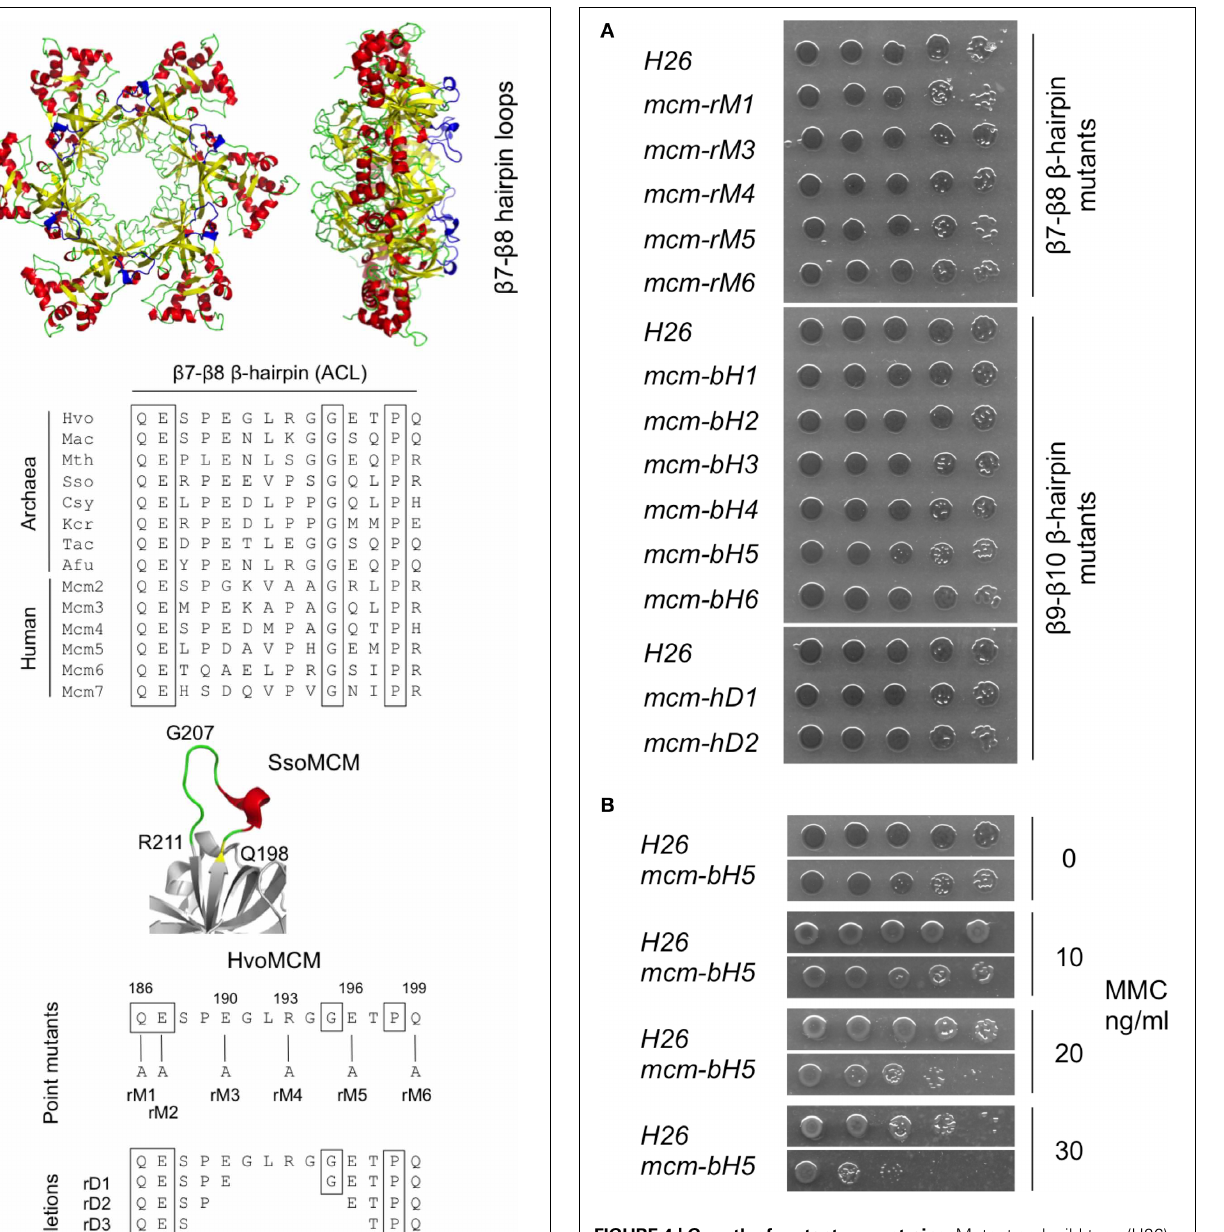
FIGURE 4 | Growth of mutant mcm strains. Mutant and wild-type (H26) strains were grown to mid-log phase in Hv-YPC medium (OD 650nm of 0.2–0.32) before being serially diluted in 18% SW and spotted onto Hv-YPC plates (part A ) or Hv-YPC plates containing 0, 10, 20, or 30ng/ml mitomycin C (MMC, part B, only H26 and mcm-bH5 are shown). The plates were then incubated for 5 days at 45 ◦ C. β 9- β 10 β -hairpin loop mutant mcm-bH5 is significantly more sensitive to MMC than wild-type (H26). or double-stranded DNA is thought to pass (Slaymaker and Chen, 2012). One of these hairpins, the positively charged β 9- β 10 β -hairpin (also known as the NT-hairpin) is located in the N-terminal domain of the protein (see Figure 5A ). Unlike the β 7- β 8 loop described above, the sequence of this part of the MCM protein is not well-conserved across evolution ( Figure 5B